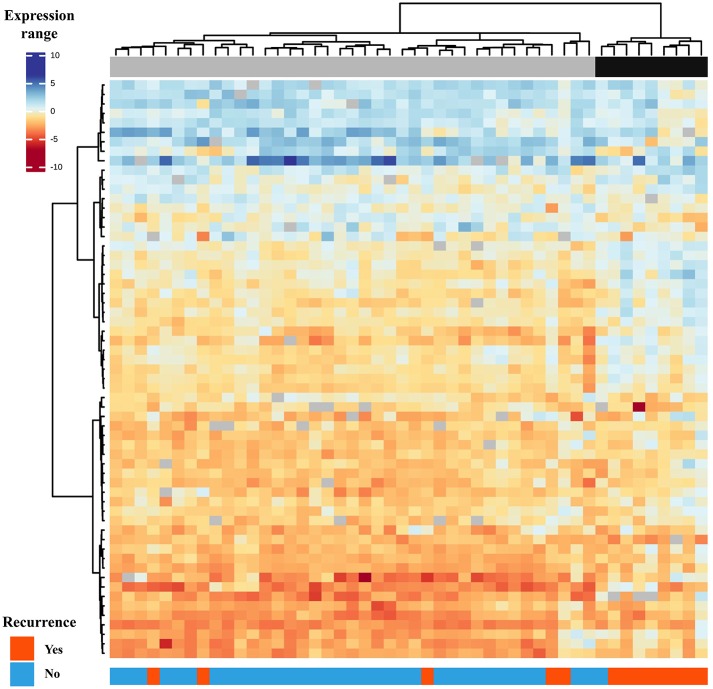
Supervised hierarchical clustering analysis comprising 61 genes differentially expressed in primary PTC-RE compared to PTC-FCO (samples in columns and genes in rows). Two major groups are shown: the first (gray) is enriched by patients with favorable clinical outcomes and the second (black) by patients who relapsed in the follow-up.